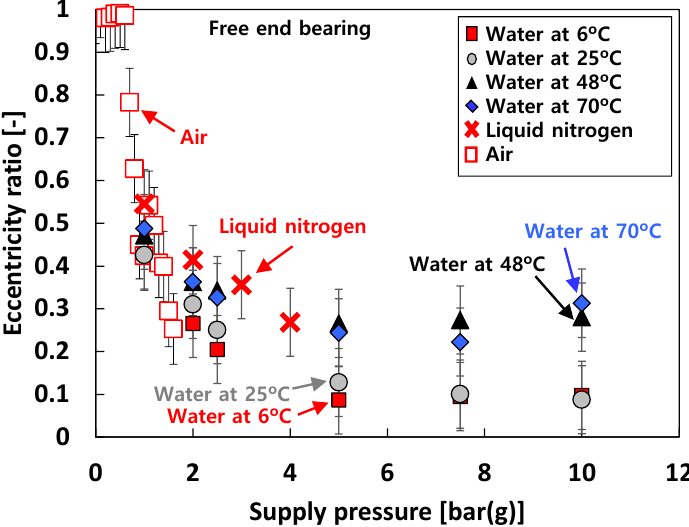
Figure 8. Test cases #1 through #3: measured bearing eccentricity ratio versus supply pressure. Free end bearing. Static load on the bearing: ~55 N.